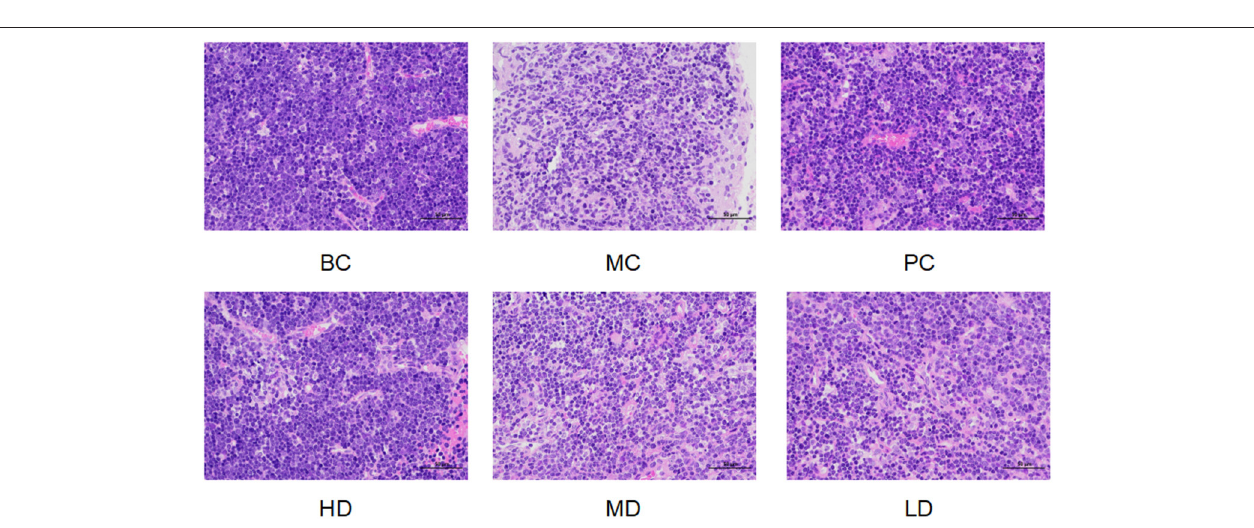
Figure 6C , the differential protein subcellular localization of HD and MC differential proteins were more distributed in cyto (cytosol), nucl (nucleus), plas (plasma membrane) and extr